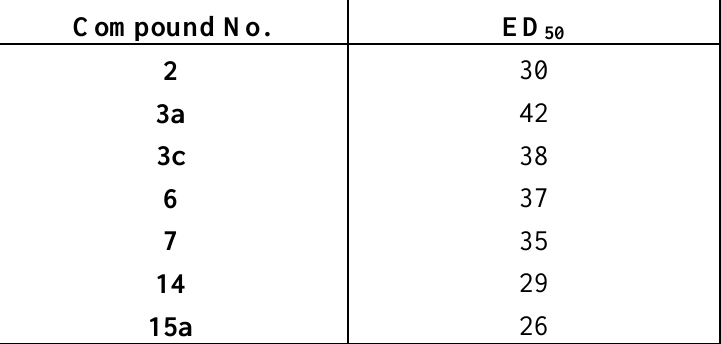
Table (5): Cytoxic activity against breast cancer B Compound